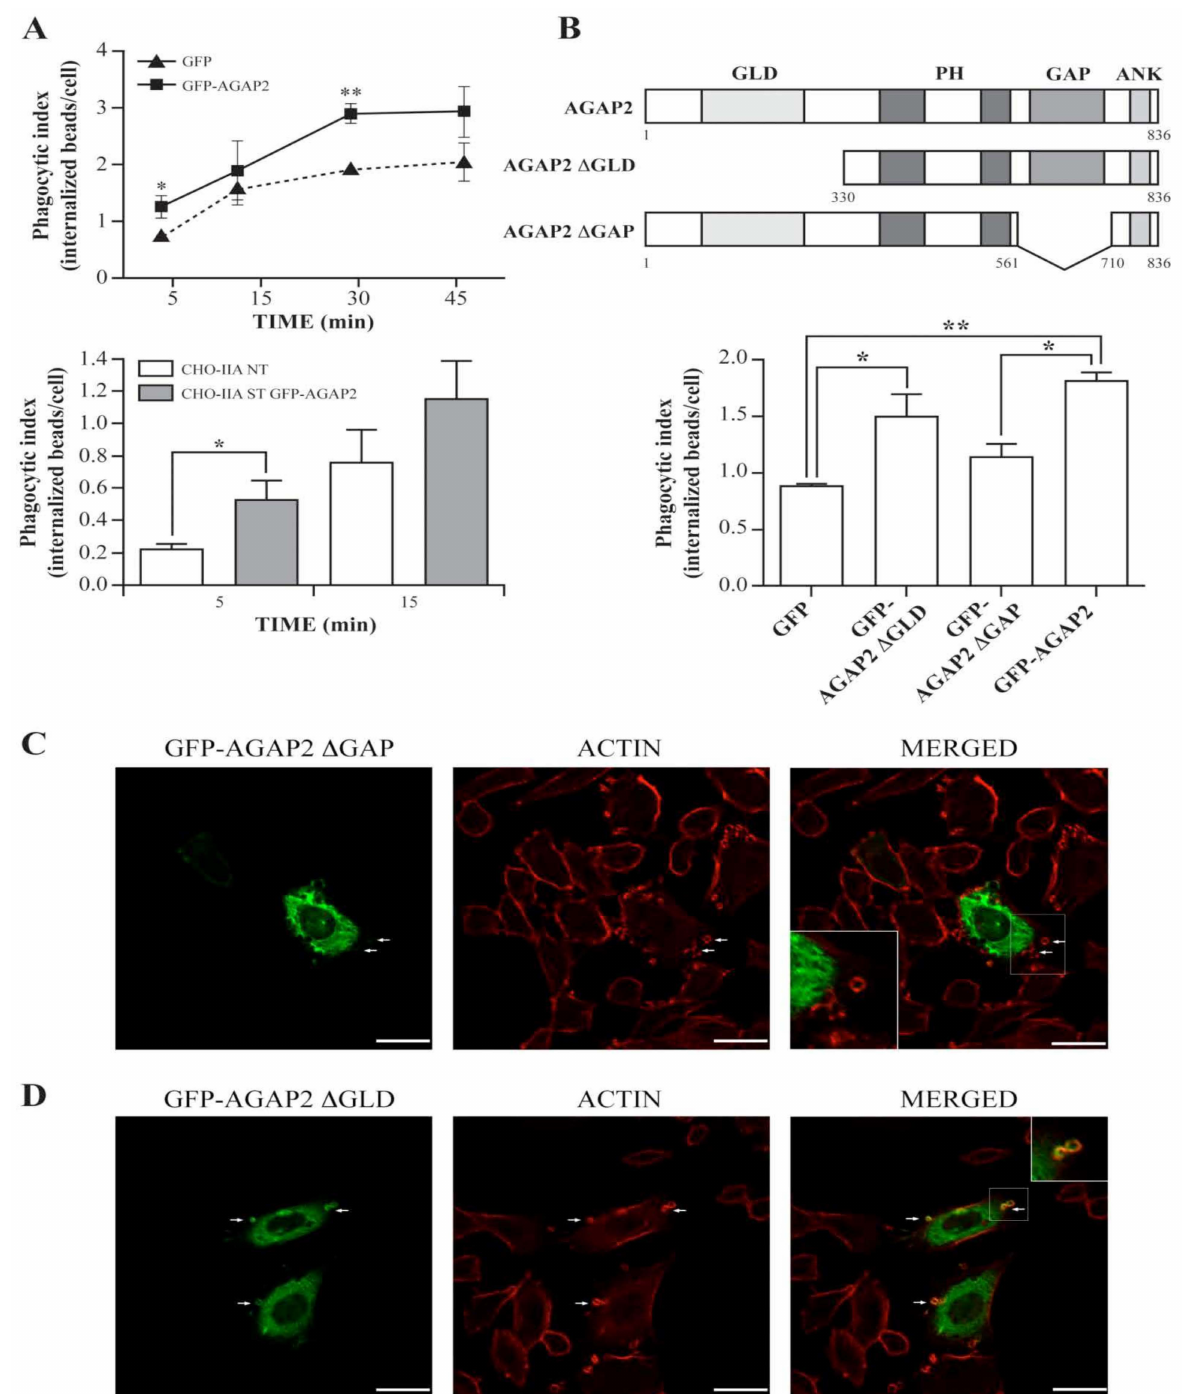
Figure 6. Impact of pEGFP-C1-AGAP2 on Fc γ -mediated phagocytosis. ( A ) CHO-IIA cells transiently (upper panel) or stably (lower panel, CHO-IIA ST GFP-AGAP2) expressing pEGFPC1-AGAP2 were incubated with IgG-opsonized latex beads (bead-to-cell ratio of 15:1) for the indicated times. External beads were distinguished from phagocytosed beads by staining with Texas Red-labeled donkey anti- human IgG antibody. Non-transfected CHO-IIA (CHO-IIA NT) cells and/or CHO-IIA transiently expressing GFP were used as controls. The phagocytic index was calculated as described in Section